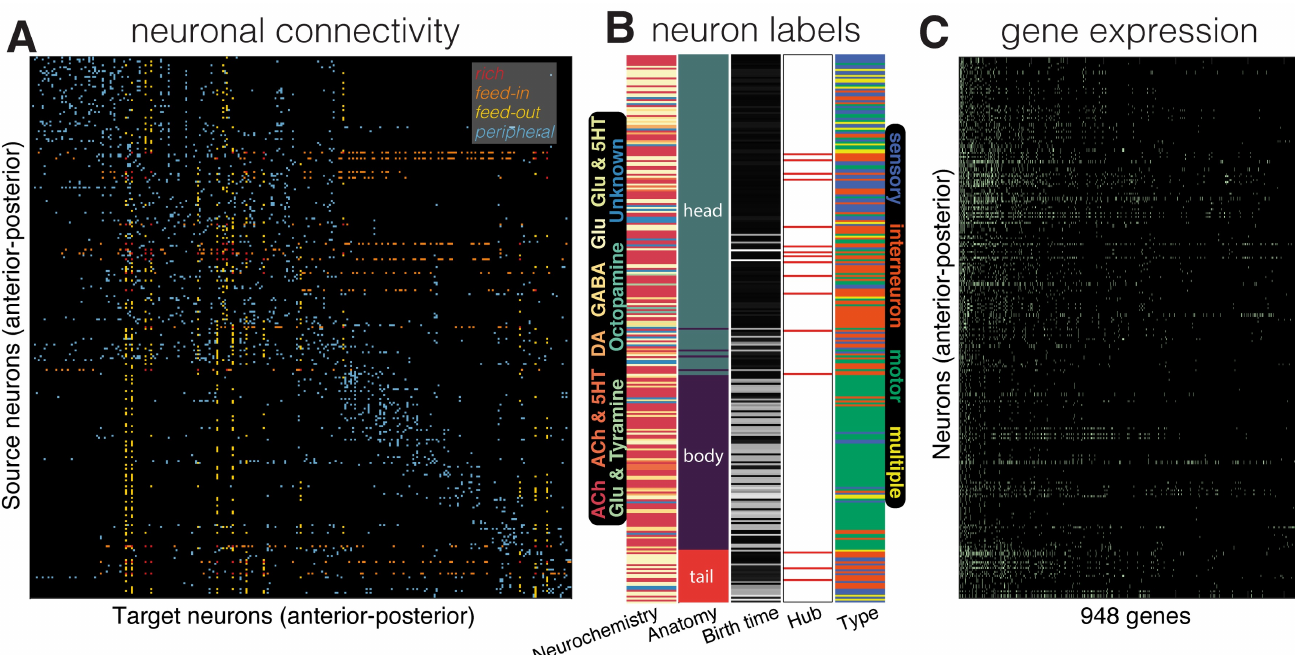
Fig 1. Schematic representation of the data used in this study. All plots show neurons (rows) ordered by anterior-posterior along the longitudinal axis, from the top of the head (upper, left) to the bottom of the tail (lower, right). (A) Connectivity matrix summarized 2990 directed chemical and electrical connections between 279 neurons from neuron i (row) to neuron j (column). Connections are colored according to how they connect hubs ( k > 44) and nonhubs ( k (cid:20) 44), as ‘rich’ (hub ! hub), ‘feed-in’ (nonhub ! hub), ‘feed-out’ (hub ! nonhub), and ‘peripheral’ (nonhub ! nonhub). (B) Neurochemistry (types as labeled), anatomical location (as labeled), birth time (from early born neurons, black, to late-born neurons, white), hub assignment (hubs labeled red), and functional type (as labeled). (C) Binary gene expression indicated as a green dot when a gene (column) is expressed in a neuron (row).